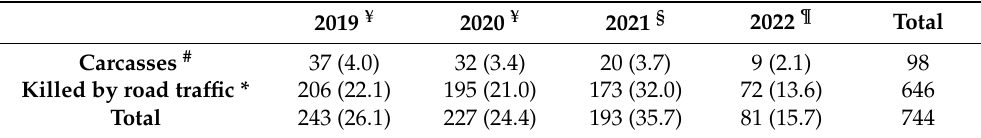
Table 3. The number of wild boar sampled and tested by passive surveillance in the infected zone divided by carcasses and wild boar killed by road traffic from the 9 April 2019 to 15 June 2022.